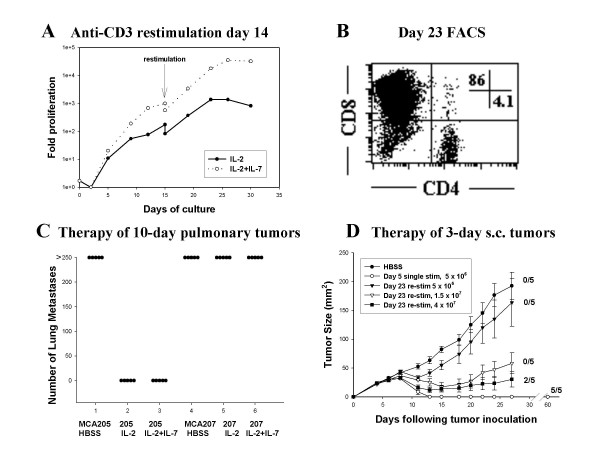
Restimulation of activated T cells induces additional proliferation with retention of specific anti-tumor efficacy. (A) CD62Llow TDLN cells were activated with anti-CD3 mAb from day 0–2 and again for 14 hrs on day 15. T cells were cultured in the presence of IL-2 (4 U/ml) (closed circle) or IL-2 plus IL-7 (10 ng/ml) (open circle) and the total proliferation is indicated. (B) FACS analysis of activated T cells on day 23 of culture stained for CD4 and CD8. (C) Mice bearing 10-day pulmonary metastases of either MCA205 or MCA207 tumors were pre-treated with 5 Gy TBI then received adoptive transfer of 2.5 × 107 cells cultured with IL-2 alone, the combination of IL-2 plus IL-7, or control HBSS as indicated. Difference between the groups bearing MCA 205 treated with T cells cultured with IL-2 or IL-2 plus IL-7 and all other groups is (P < 0.01). (D) Mice bearing 3-day s.c tumors were pre-treated with 5Gy TBI followed by injection of; HBSS (closed circles), 5 × 106 T cells activated for 5 days (open circles, P < 0.01), 5 × 106 restimulated T cells at day 23 of culture (closed triangles, P = 0.4), 1.5 × 107 re-stimulated T cells (open triangle, P < 0.01), or 4 × 107 re-stimulated T cells (closed square, P < 0.01). Number of mice showing complete regression in each treatment group of 5 mice is indicated in parentheses.